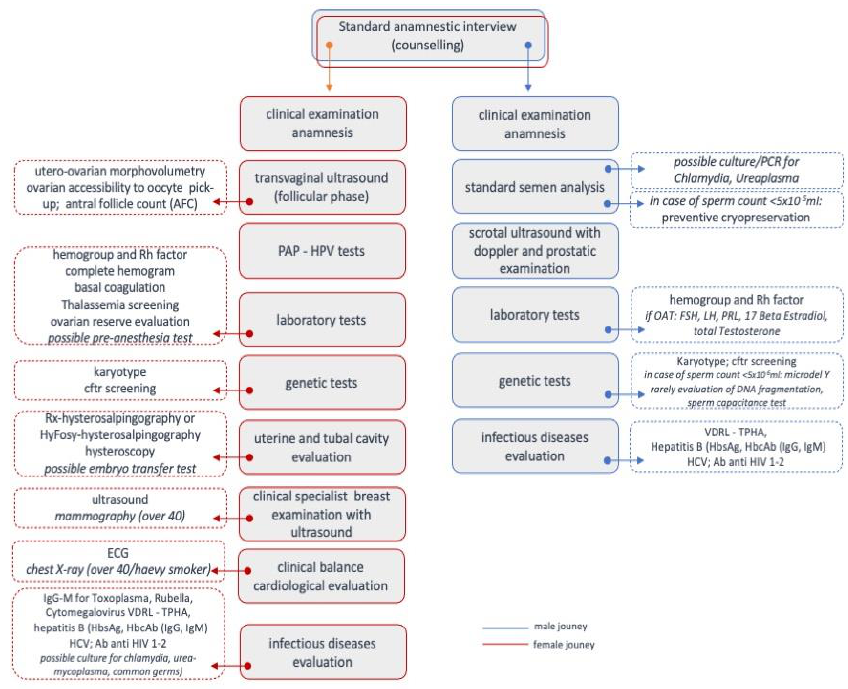
Figure 2. The infertile couple is subjected to instrumental and laboratory investigations to define the most appropriate diagnosis and therapy. The figure shows the most common diagnostic examinations prescribed to the women (red line) and the men (blue line), as derived by the analysis of the studies and the experience of the ART clinics involved in this study.